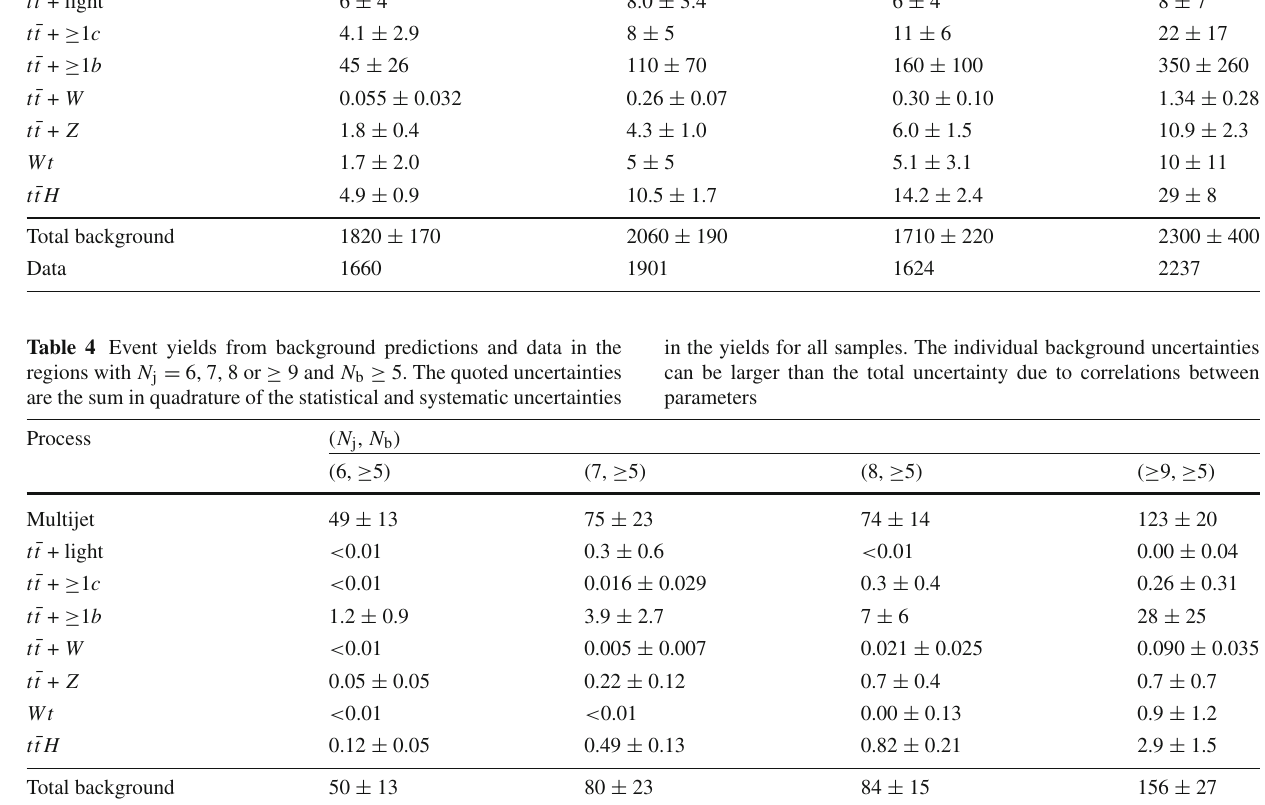
in the yields for all samples. The individual background uncertainties can be larger than the total uncertainty due to correlations between